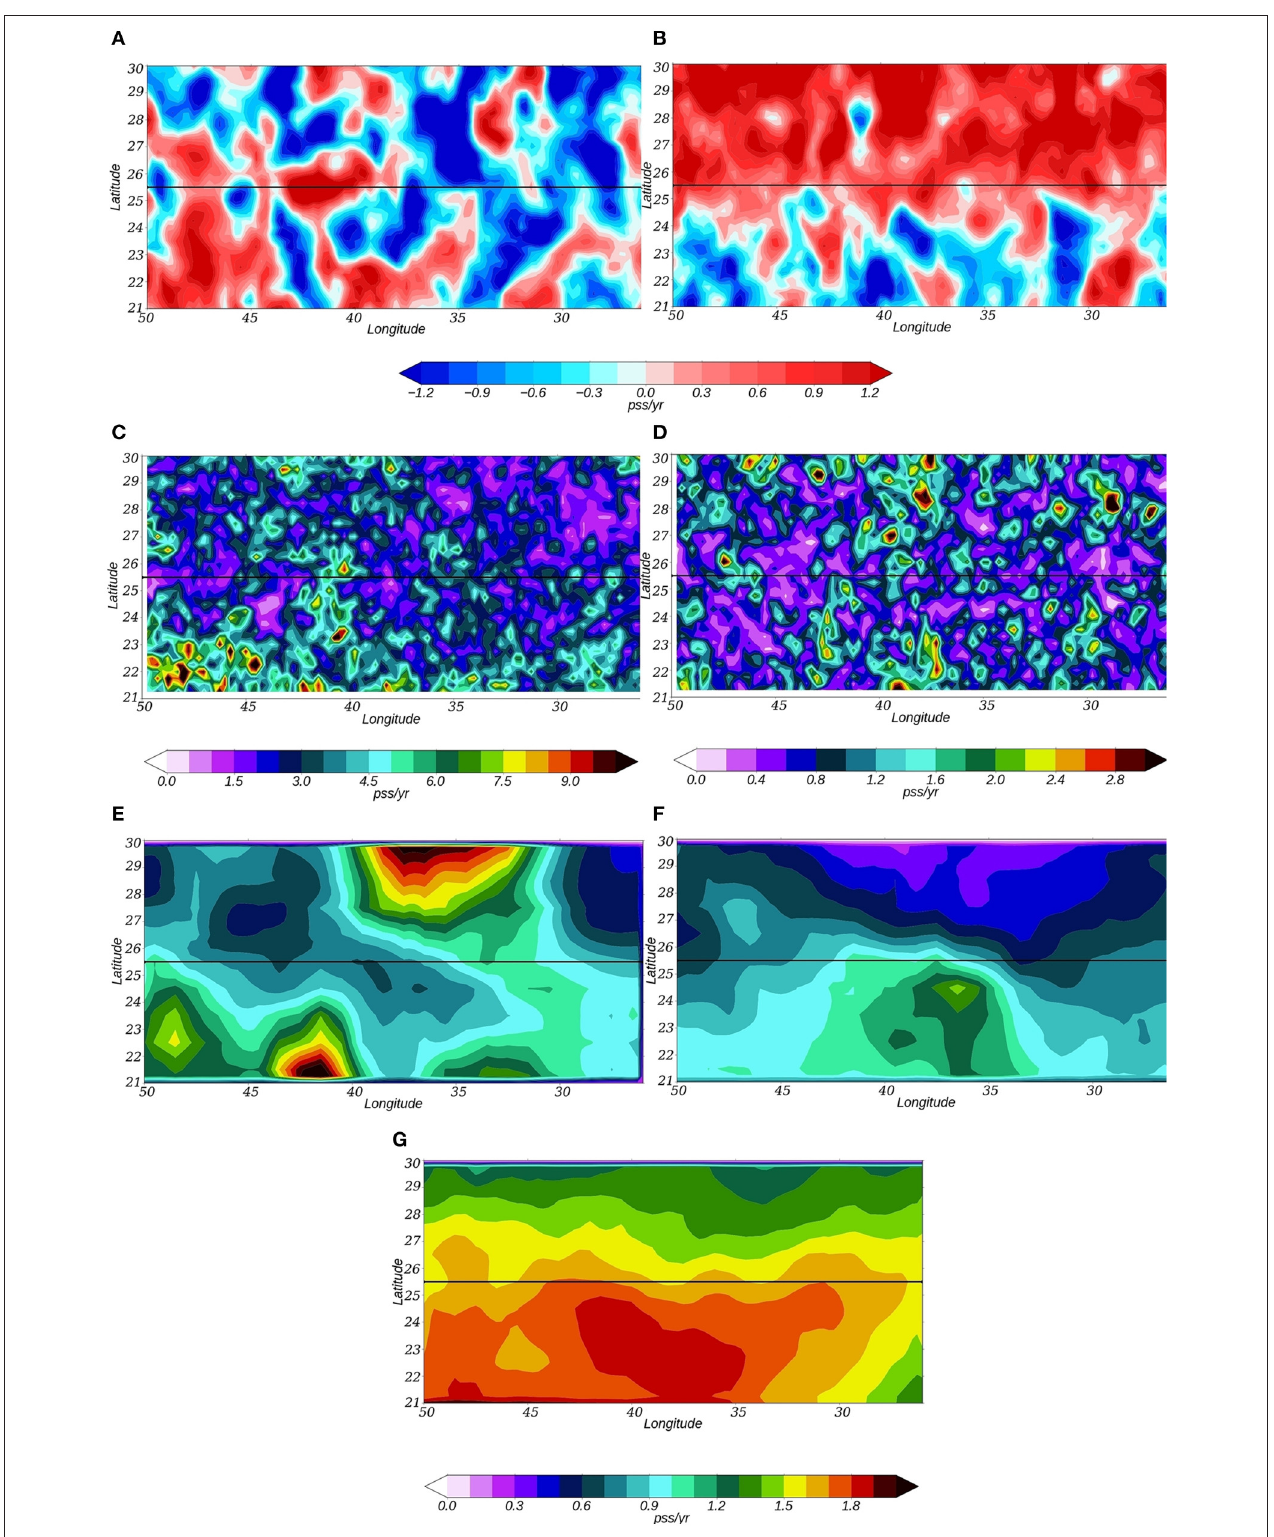
FIGURE 10 | Sea surface salinity change in winter (A) and summer (B). Turbulent advection standard deviation in autumn (C) and mean advection standard deviation in spring (D) . Surface forcing standard deviation in autumn (E) and spring (F) and surface forcing mean in summer (G) .